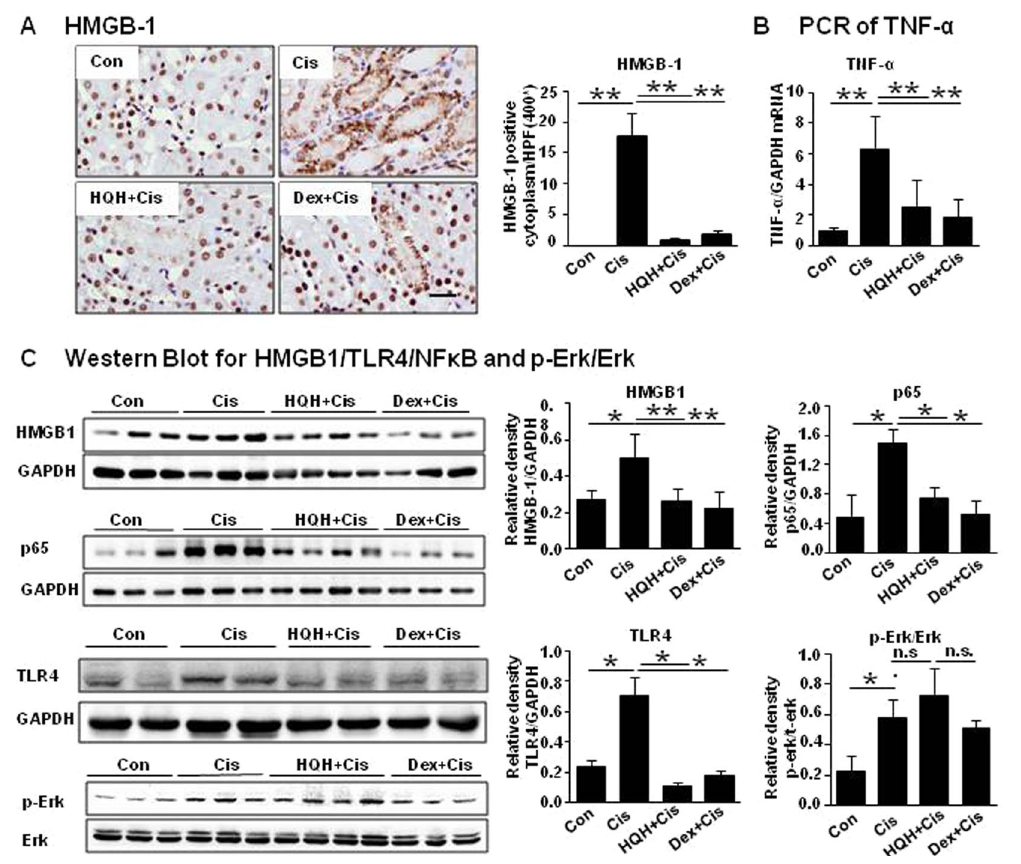
Figure 3. HQH protected the kidney through inhibition of HMGB1/TLR4/NF- κ B/TNF- α pathway. ( A ) Representative photomicrographs and graphs for the expression of HMGB1 by immunohistochemical staining ( ** P < 0.01, n = 5/group). Bar = 50 μ m. ( B ) Real-time PCR analyses of TNF- α ( ** P < 0.01, n = 3 ~ 7/group). ( C ) Representative Western blot and graphs for HMGB-1 in cytoplasmprotein ( ** P < 0.01, * P < 0.05, n = 3 ~ 4/ group) and p65 in nucleoprotein ( * P < 0.05, n = 3 ~ 4/group), and TLR4 ( * P < 0.05, n = 4/group), p-Er and Erk ( * P < 0.05, n = 3/group) in total protein. Each group of blots is the same exposure of a gel, each group of results repeated more than three times.